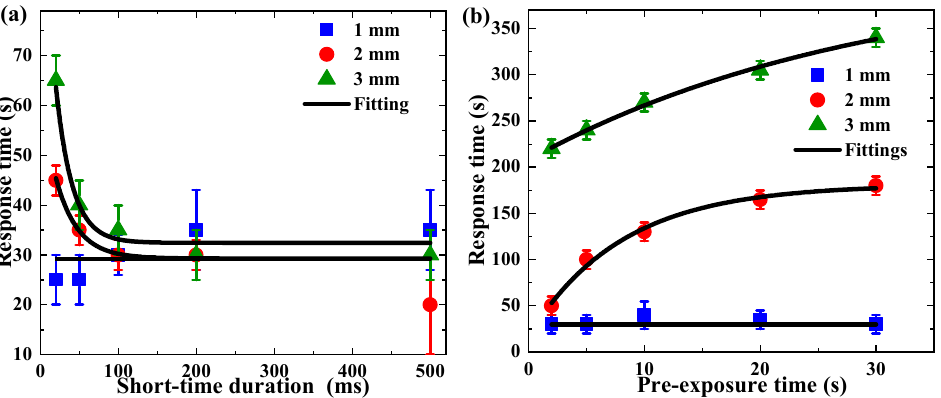
Figure 9. The response time in DDEP: ( a ) single shot with different short-time durations, ( b ) long-time pre-exposure with different times.